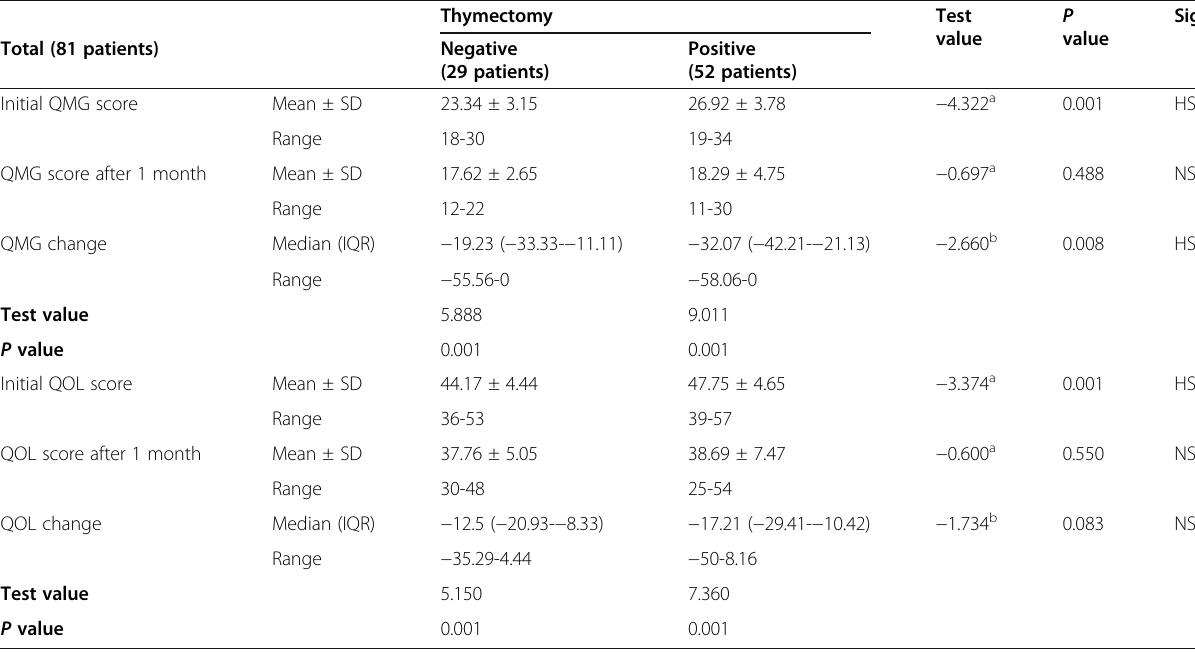
Thymectomy Test